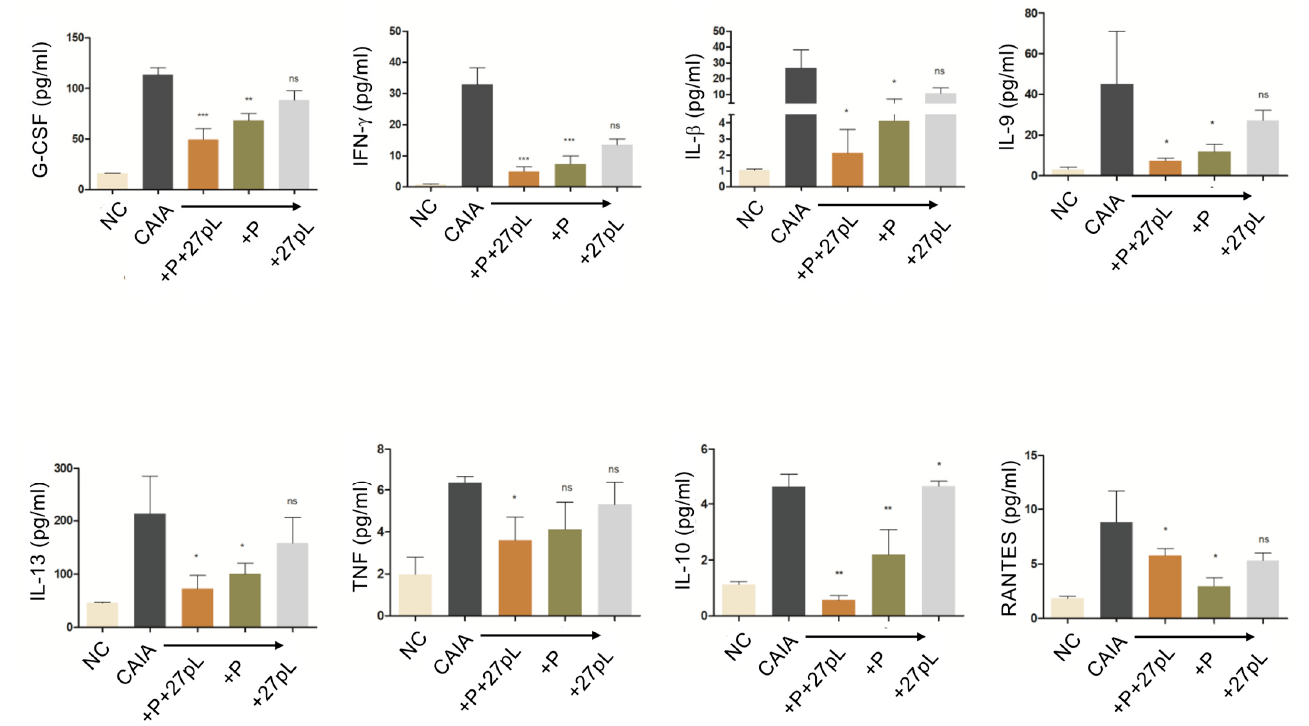
Figure 7. Cytokine quantification in the serum of the no CAIA (NC, − control), CAIA mice (+ control), P-treated, and 27pL-treated CAIA mice using a multiplex cytokine assay. On day 10 post-induction, all animals were euthanized, and the serum was obtained for analysis. NC displayed the basal expression levels reported here. CAIA mice had a significant increase in all cytokines produced. P + 27pL markedly decreased the levels of IL-10, IL-6, TNF- α , IFN- γ , IL-13, IL-1 β , G-CSF, and RANTES in the serum of CAIA mice. Results represent mean ± SEM. This figure is the combination of two different experiments. A one-way analysis of variance (ANOVA) followed by Tukey’s multiple comparison t -test was used to calculate the statistical difference (* p ≤ 0.05; ** p ≤ 0.01; *** p ≤ 0.001), with ns, not significant.